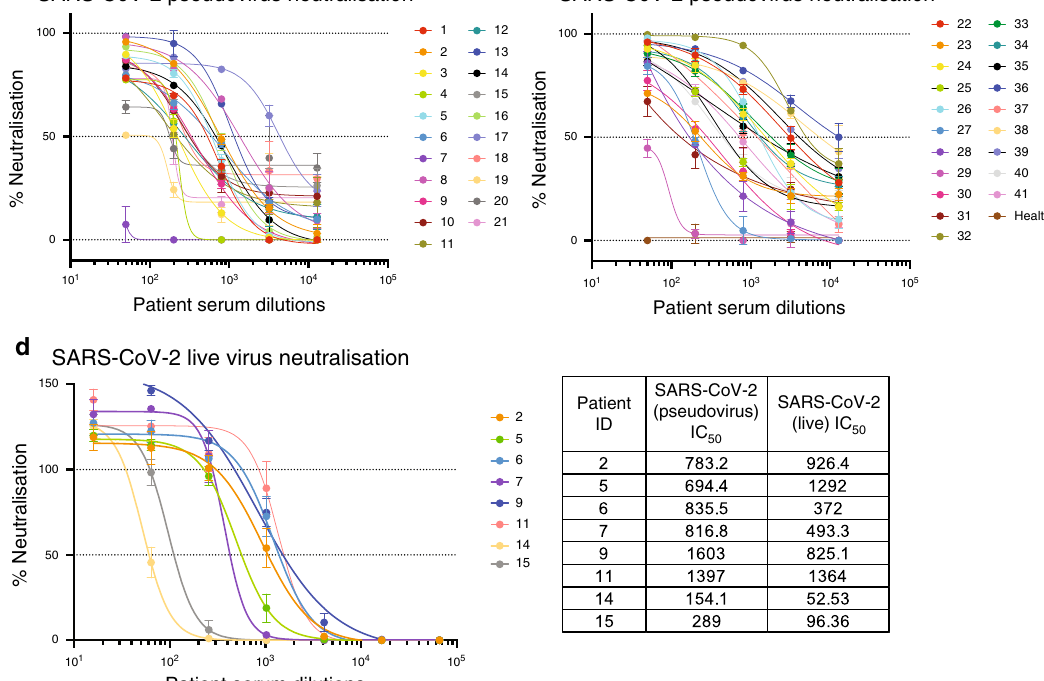
Fig. 1 COVID-19 patient sera can neutralise pseudotyped lentiviruses expressing SARS-CoV-2 spike protein. a Sera of COVID-19 patients ( n = 25) at 1:1000 dilution were incubated with luciferase expressing lentiviruses pseudotyped with SARS-CoV-2 spike (S) glycoprotein protein for 1 hour prior to infection of CHO-ACE2 cells for 48 hours. Infection levels were determined by luciferase assay, and percentage of neutralisation is presented. Recalled SARS patients ( n = 13) and healthy controls (HC) were also conducted in parallel. Dotted lines correspond to 50% neutralisation and baseline of HC. b Sera of recalled SARS patients ( n = 13, 1:100 dilution) or a healthy control (Healthy) were mixed with pseudotyped lentivirus expressing SARS-CoV or SARS-CoV-2 S glycoprotein, prior to incubation with CHO-ACE2 cells for 48 hours. Infection levels were determined by luciferase assay, and percentage neutralisation was analysed. c Dose – response neutralisation of pseudotyped lentivirus titration curves of COVID-19 patients ( n = 41, 1:50 to 1:12,800 dilutions). d Dose – response neutralisation of live SARS-CoV-2 virus titration curves of COVID-19 patients ( n = 8, 1:16 to 1:65,536 dilutions). Comparison table of IC 50 values from two assays. Lines represent non-linear regression robust fi t. Source data are provided as a Source Data